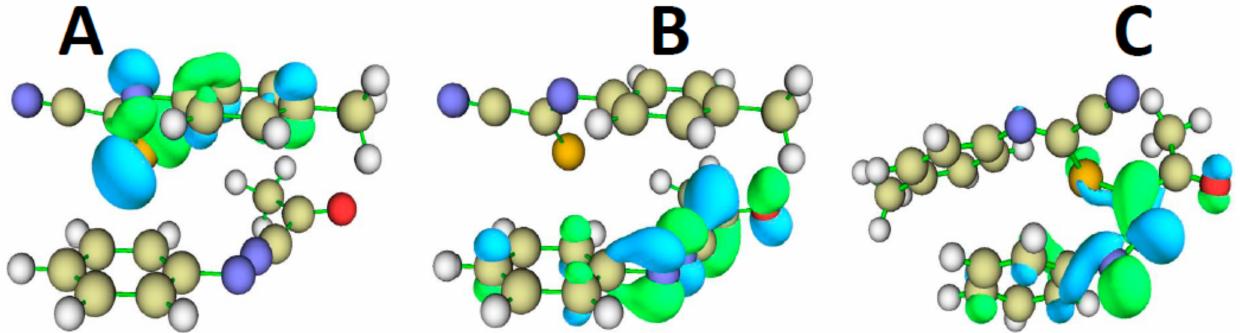
Figure 9. Isosurface representation of the Frontier Molecular Orbitals (FMO) for HOMO ( A ) and LUMO ( B ) for the unreacted complex of 29 (bottom molecule) with 27 (top molecule). The HOMO for the intermediate state is shown in ( C ). The level of theory is B3LYP-D4/def2-TZVP. The isosurface value is +/ − 0.05 a.u., with the green and blue regions corresponding to the positive and negative signs of the FMO, respectively. Color code for atoms: grey = C, blue = N, red = O, yellow = S, and white =